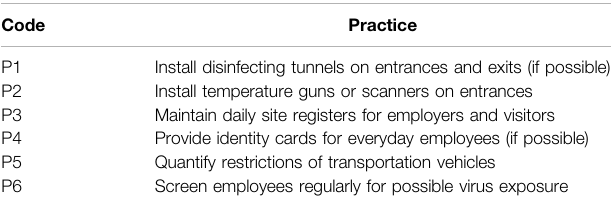
TABLE 3 | Recommended practices to control access